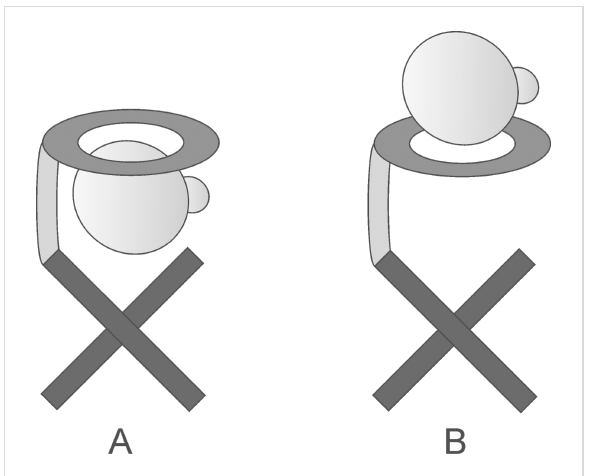
templates, and thereby, contribute to the binding affinity by attractive dispersive